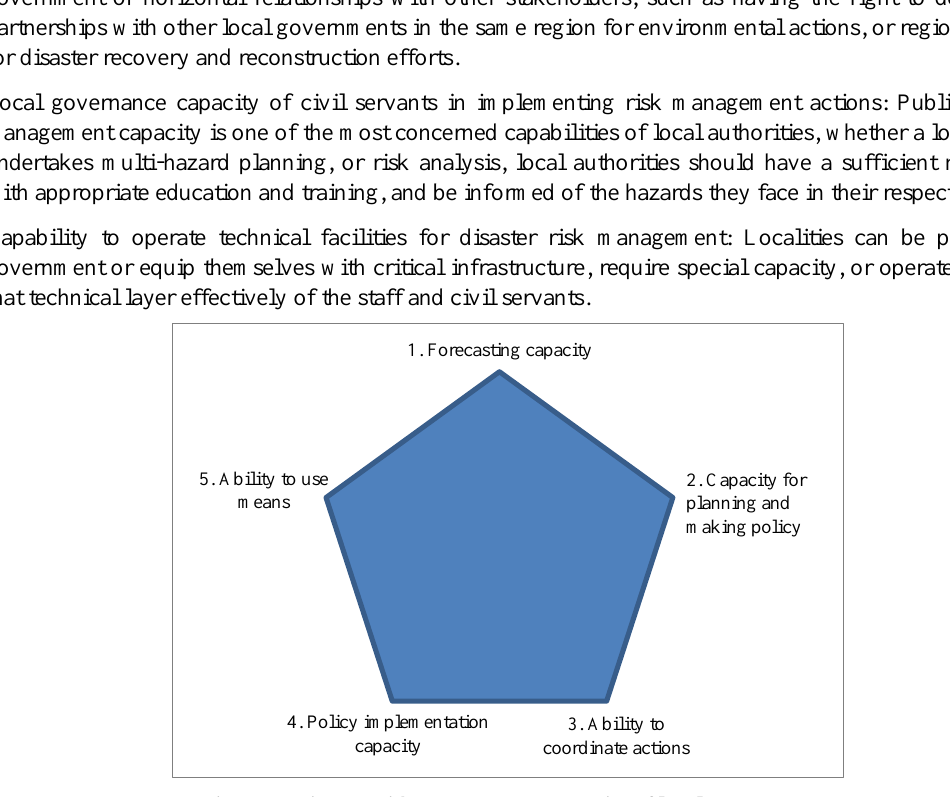
Figure 1. Disaster risk management capacity of local government